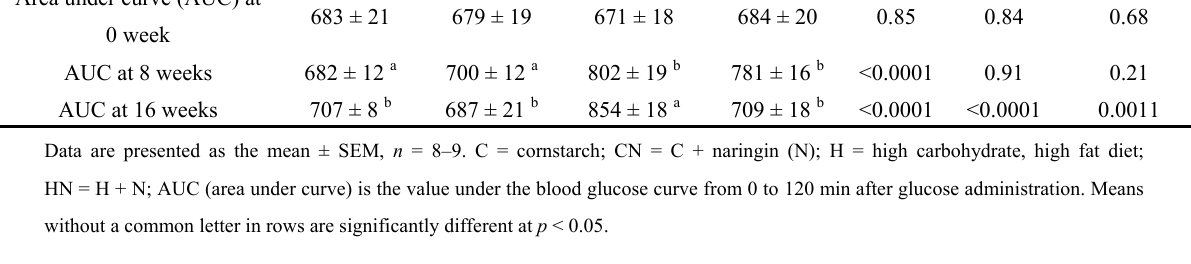
Table 2. Naringin on plasma parameters in C and H-diet fed